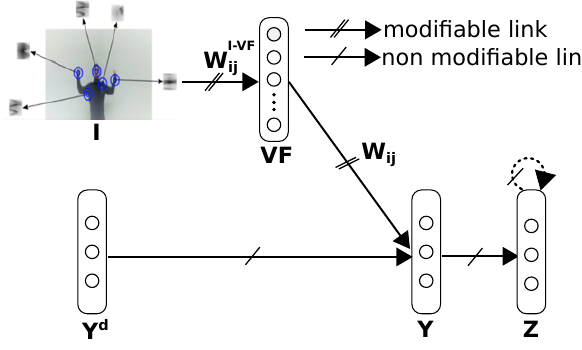
Figure 2: Sensory-motor architecture (PerAc).